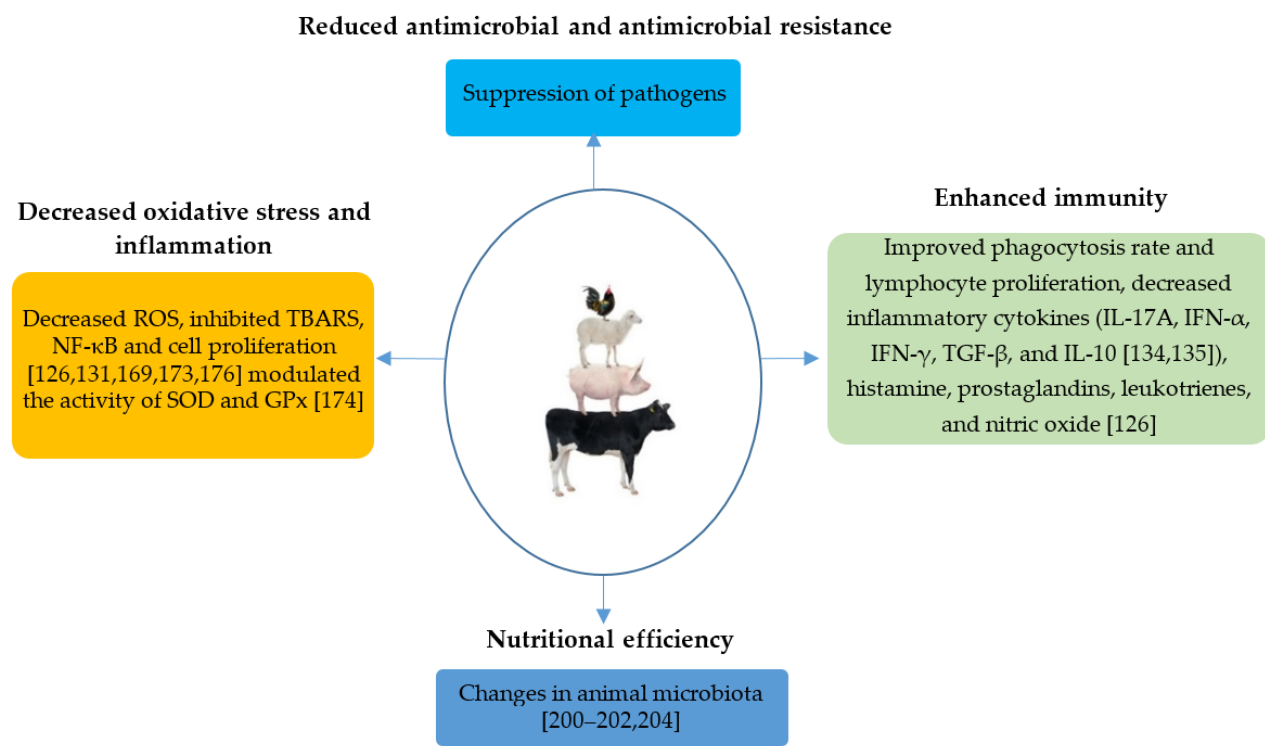
Figure 6. EOs in livestock from a One Health perspective. IL: Interleukin; NF-κB: Nuclear Factor Kappa B; TGF-β: Transforming growth factor-beta; IFN: Interferon; GPx: Glutathione peroxidase; SOD: superoxide dismutase; ROS: Reactive oxygen species, TBARS: Thiobarbituric acid-reactive species.